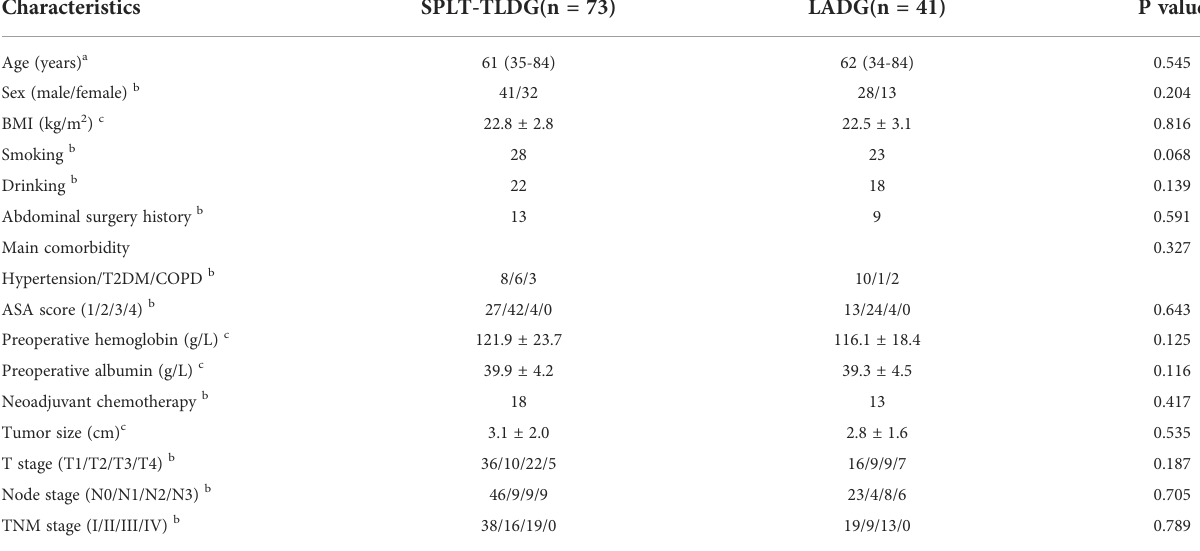
TABLE 1 Patient demographics and tumor characteristics of both